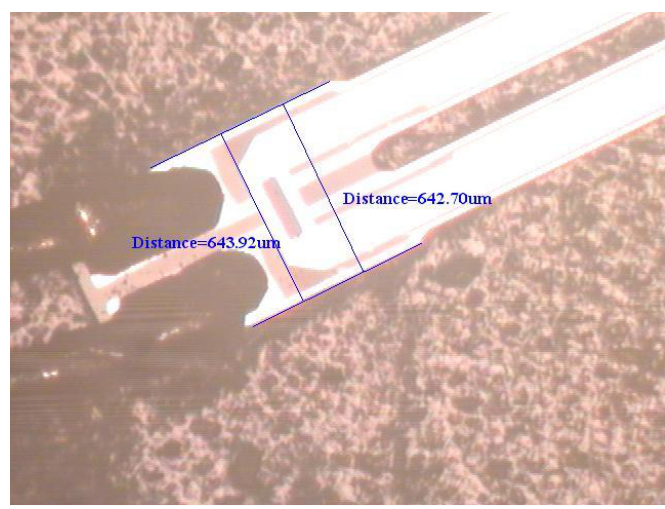
Figure 14. Determination of the gap between the two prongs from a microscope image.